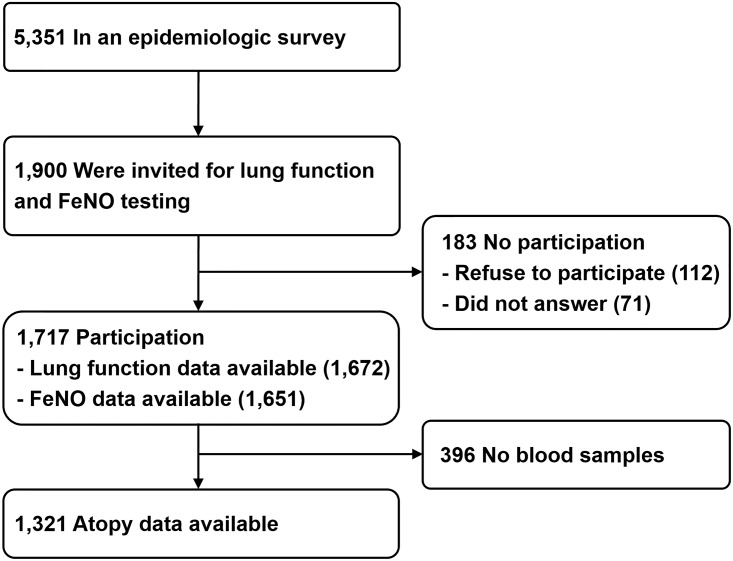
Schematic presentation of the recruitment process of the study subjects.